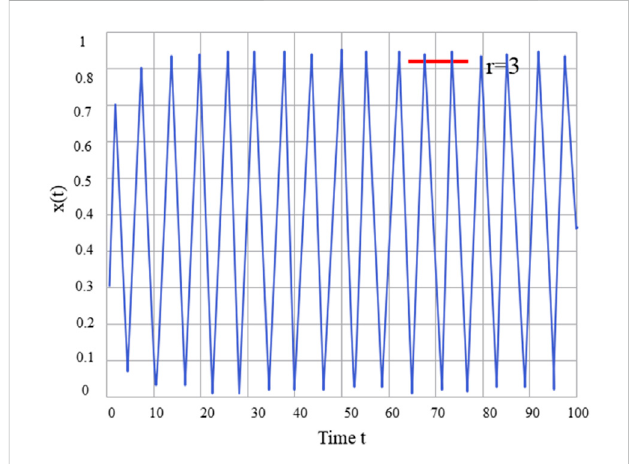
FIGURE 2 When ? = 3, the solution of Eq. 6 oscillates and does not